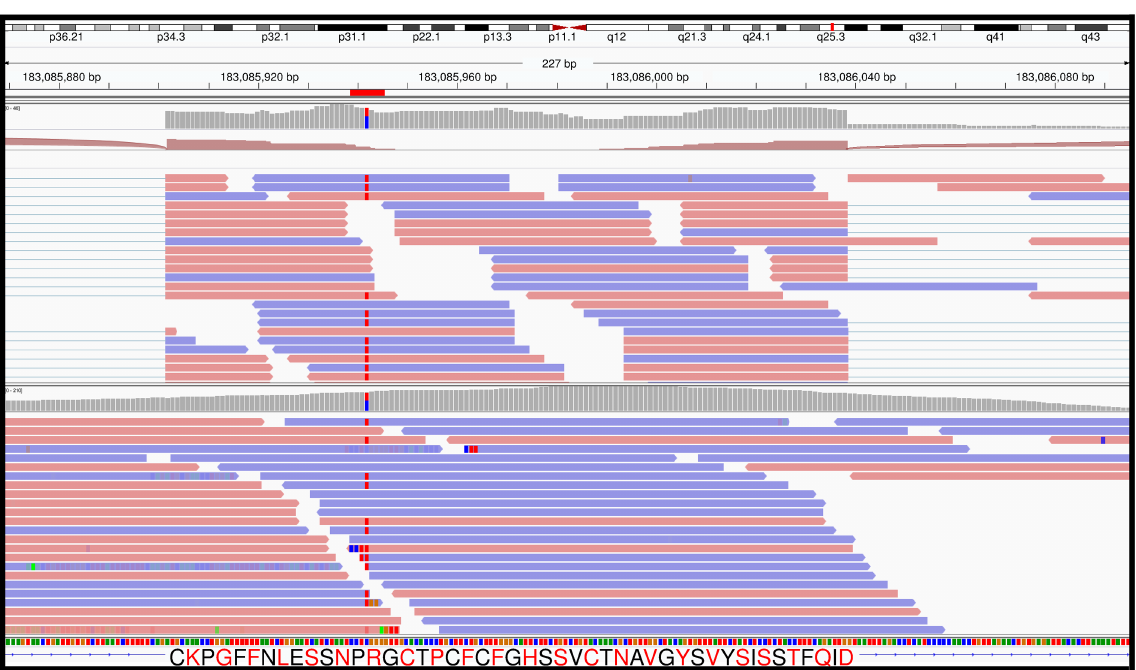
Fig 2. Identification of a rare LAMC1 variant in RNA79 (from patient 2011–291). RNASeq (top panel) and exome sequencing data (bottom panel) from the same individual are shown. The location of a C- > T variant which leads to the R490W substitution in the LAMC1 protein is highlighted in both panels. Images were obtained from the Integrative Genomics